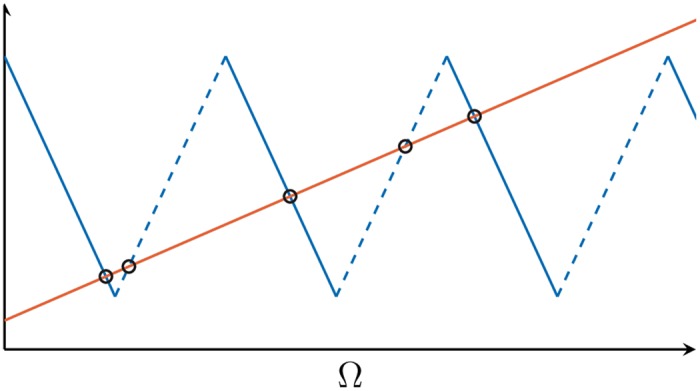
Global frequencies Ω for triangular coupling functions.Graphical representation of the lhs (red) and rhs (blue) of Eq (10) as a function of Ω. In this example, we find 5 coexisting solutions for the chosen τ-value, indicated by circles.